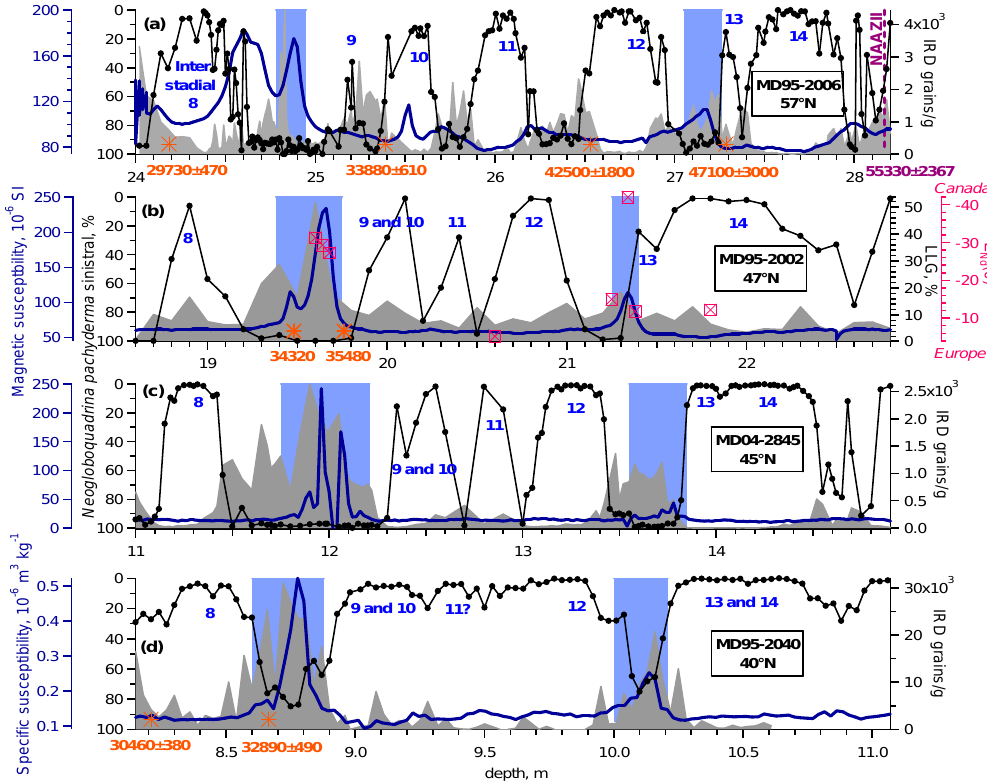
Figure 5. H4 and H5 in marine sediment records from the European margin. Core localisations are shown in Fig. 2. Each core is on its own depth scale. (a) Core MD95-2006, Barra Fan, 57 ◦ 01 (cid:48) 82N, 10 ◦ 03 (cid:48) 48W (Peters et al., 2008; Dickson et al., 2008). (b) Core MD95- 2002, Celtic margin, 47 ◦ 27 (cid:48) 12N, 8 ◦ 27 (cid:48) 03W (Auffret et al., 2002). (c) Core MD04-2845, Bay of Biscay, 45 ◦ 21 (cid:48) N, 5 ◦ 13 (cid:48) W (Sánchez Goñi et al., 2008). (d) Core MD95-2040, Portuguese margin, 40 ◦ 34 (cid:48) 91N, 9 ◦ 51 (cid:48) 67W (de Abreu et al., 2003; Eynaud et al., 2009). Orange stars: uncalibrated carbon 14 age measurements (a before 1950 AD) and associated analytical uncertainties. Violet star: NAAZ (North Atlantic Ash Zone) II (Austin et al., 2004) and associated GICC05 age (a before 1950 AD) and MCE (Svensson et al., 2008). Grey shaded area: IRD or LLG (large lithic grains), counted on the > 150µm fraction. Black line and dots: abundance of the polar foraminifer N. pachyderma sinistral, %; a high percentage denotes cold sea surface temperature. Blue line: magnetic susceptibility ( a , b , c ) and specific susceptibility (d) . Pink squares: (cid:15) neodymium (Nd) of the lithic coarse fraction ( > 150µm). Low values ( ≤ 40) characterise sediment of Canadian origin, higher values ( ≥ 15) European origin. Blue shaded areas: possible Laurentide contribution to the IRD/LGG. Origin identification of IRD for core MD95-2006 based on mineral magnetic measurements (for H4 and H5, Peters et al., 2008) and an additional unpublished count of detritial carbonate grains (for H4, W. Austin, personal communication, 2014), on (cid:15) neodymium and magnetic susceptibility for core MD95-2002 (Auffret et al., 2002) and on magnetic susceptibility (as proposed by Thouveny et al., 2000, for the Iberian Margin) for cores MD04-2845 (Sánchez Goñi et al., 2008) and MD95-2040 (de Abreu et al.,